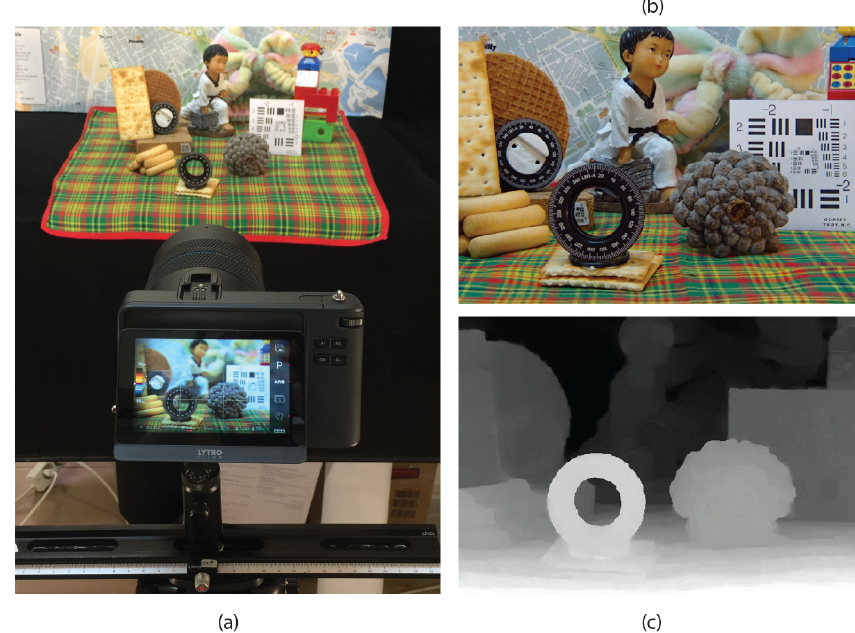
Figure 6. ( a ) Experimental set-up of the real capture of the 3D scene. ( b ) The RGB image extracted from Lytro Desktop software. ( c ) The depth map of the scene extracted from Lytro Desktop software.